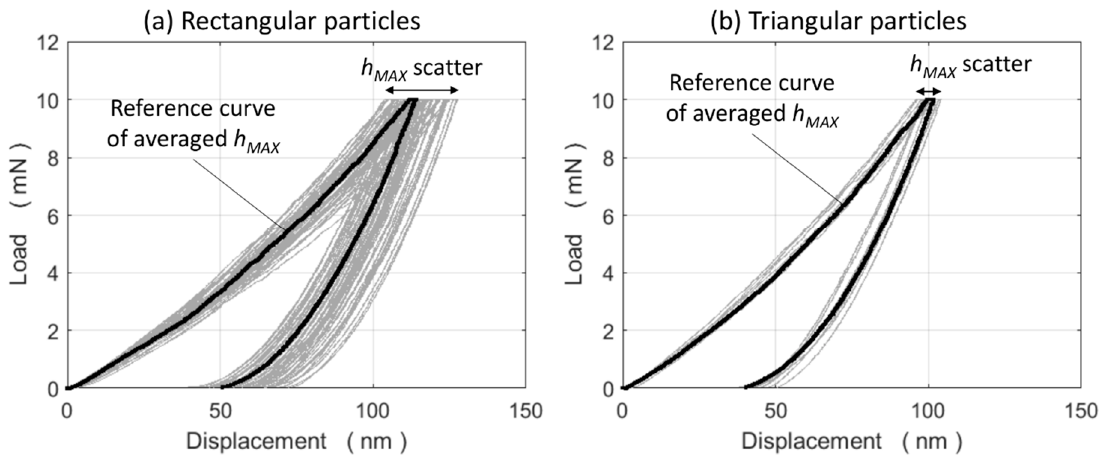
Figure 5. Nanoindentation curves of ( a ) rectangular and ( b ) triangular WC particles. An averaged maximum-indentation-depth ( h MAX ) reference curve is also shown.